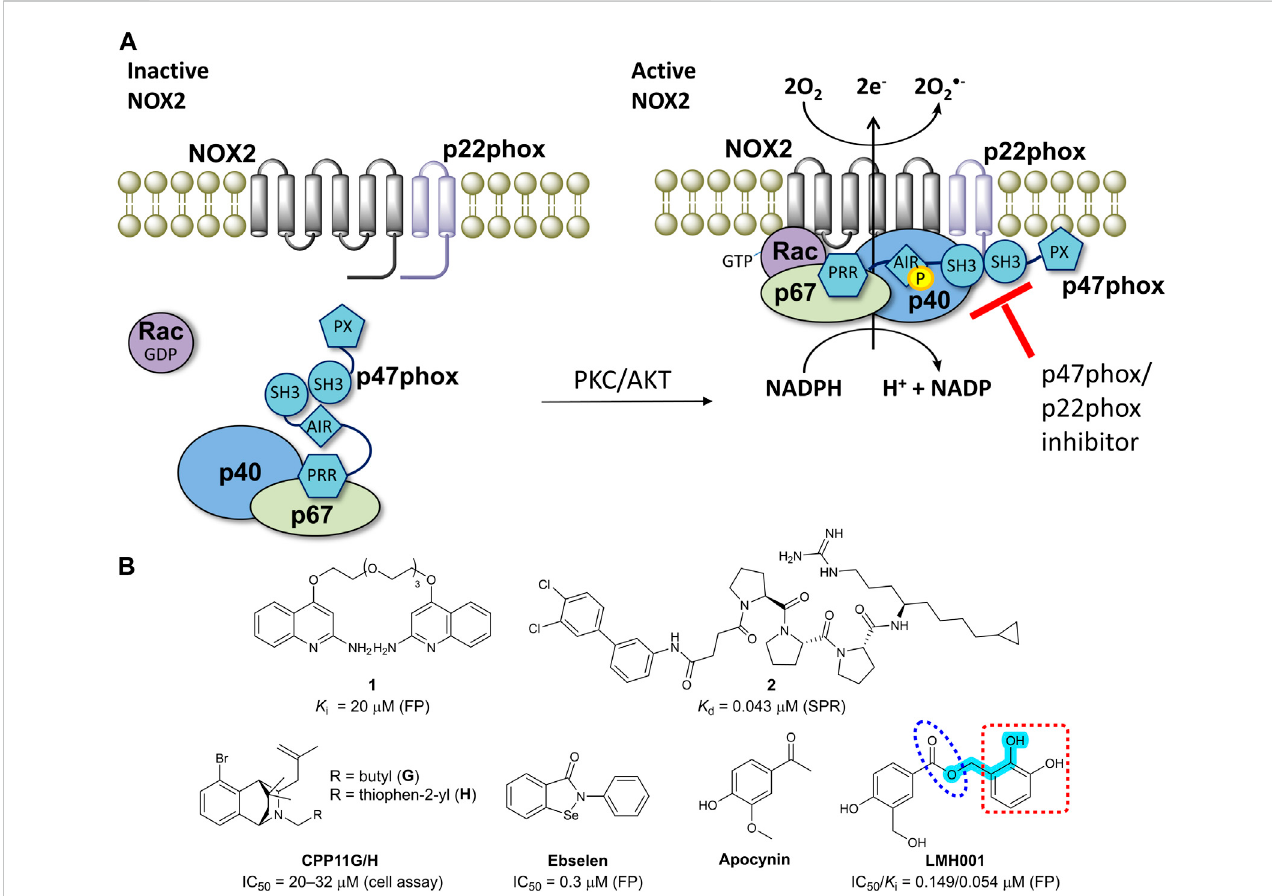
FIGURE 1 (A) The mechanism of NOX2 activation. At resting state, the cytosolic and membrane-bound subunits are separated. When p47phox is activated by the kinases(proteinkinaseC,PKCorproteinkinaseB,alsoknownasAKT),thecytosolicsubunitstranslocatetothemembraneandassemblewiththemembrane- boundsubunitstoformanactiveNOX2complex. (B) Chemicalstructuresofreportedsmall-moleculep47phox/p22phoxinhibitors.ForLMH001,keypartsare marked by turquoise color (Mannich base-like group), blue circle (ester), and a red square (catechol